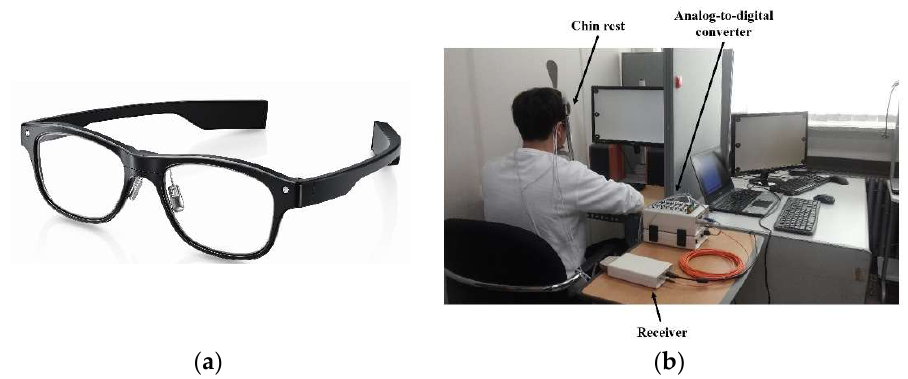
Figure 4. Devices with different styles and types of electrodes. ( a ) Dry electrodes embedded in a mobile device [52], ( b ) a typical stationary device with wet electrodes [35]. Reprinted with permission.